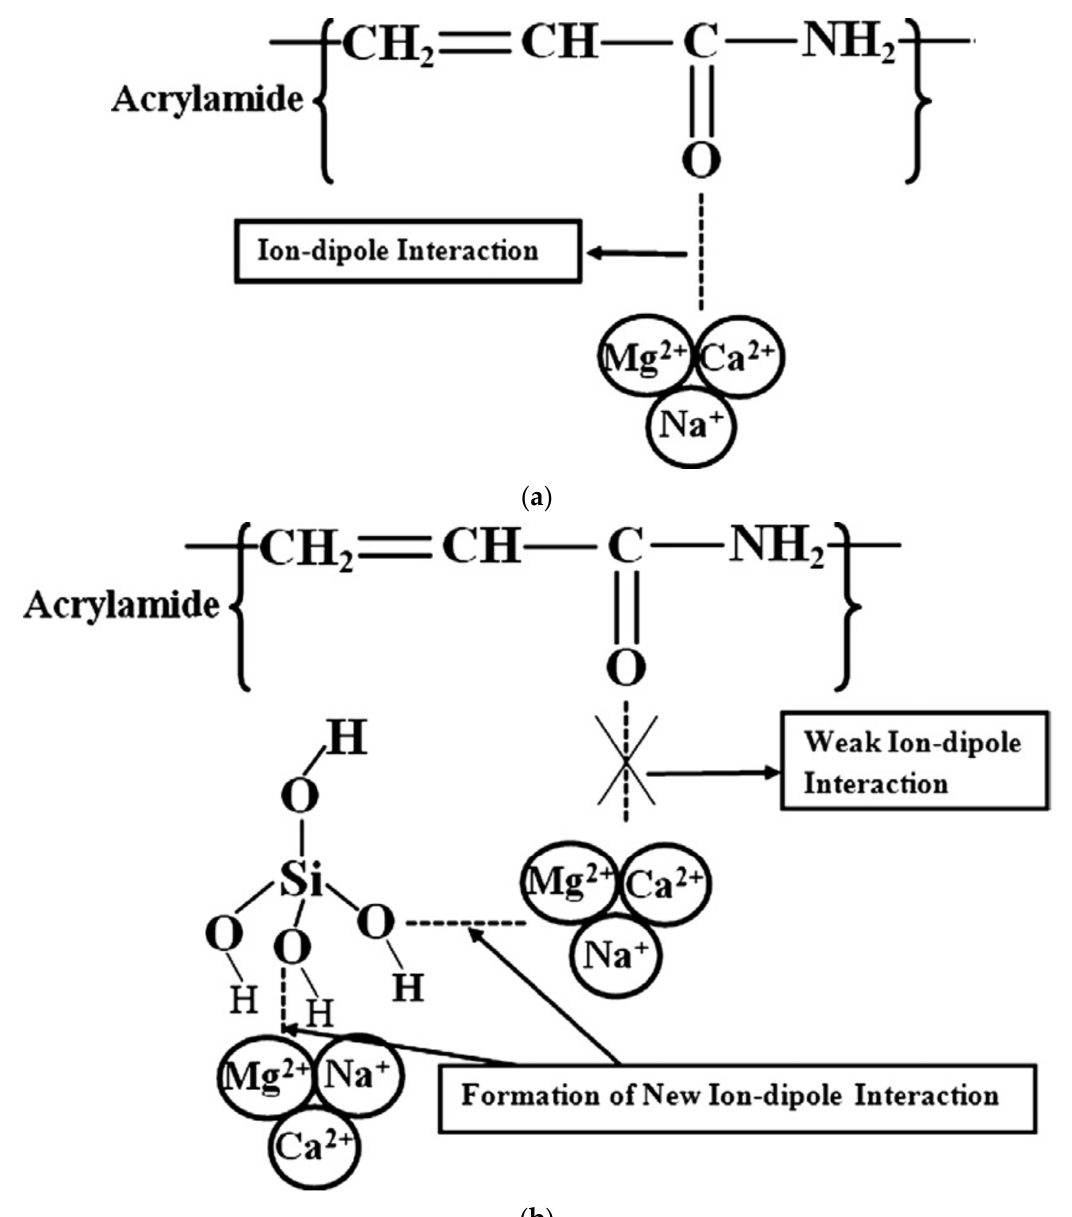
Figure 2. ( a ) Proposed interaction between magnesium, sodium and calcium cations with the carbonyl group of PAM solution without silica nanoparticles; ( b ) Weakened ion-dipole interaction with carbonyl group of PAM with the presence of silica nanoparticles due to the formation of new bonds with the nanoparticles [32].